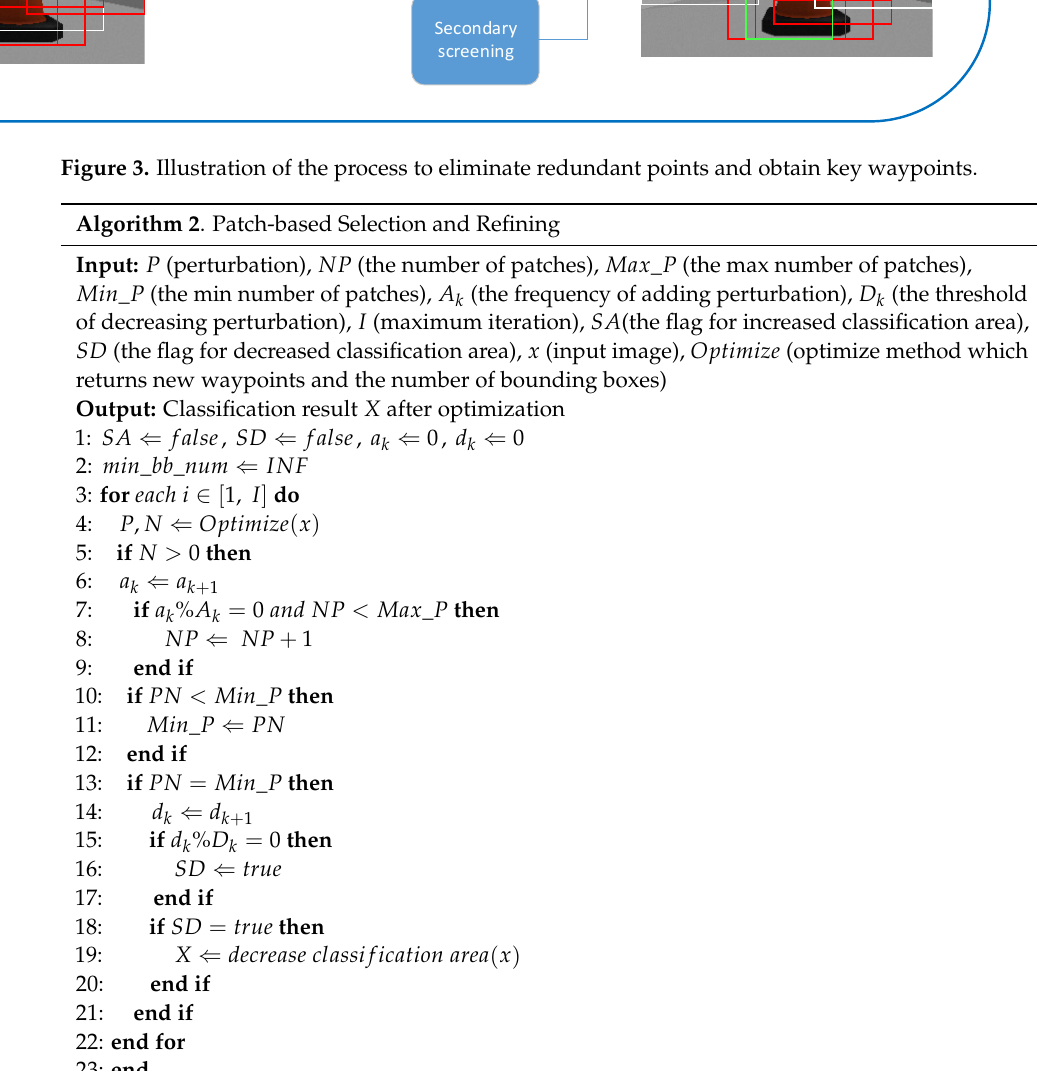
Algorithm 2 Patch-based Selection and Refining